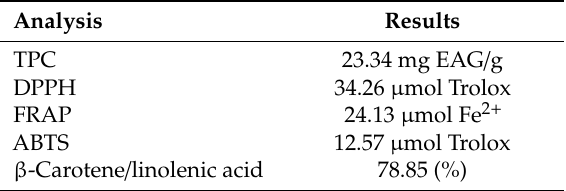
Table 3. Total phenolic compounds and antioxidant activity of Tabernaemontana catharinensis